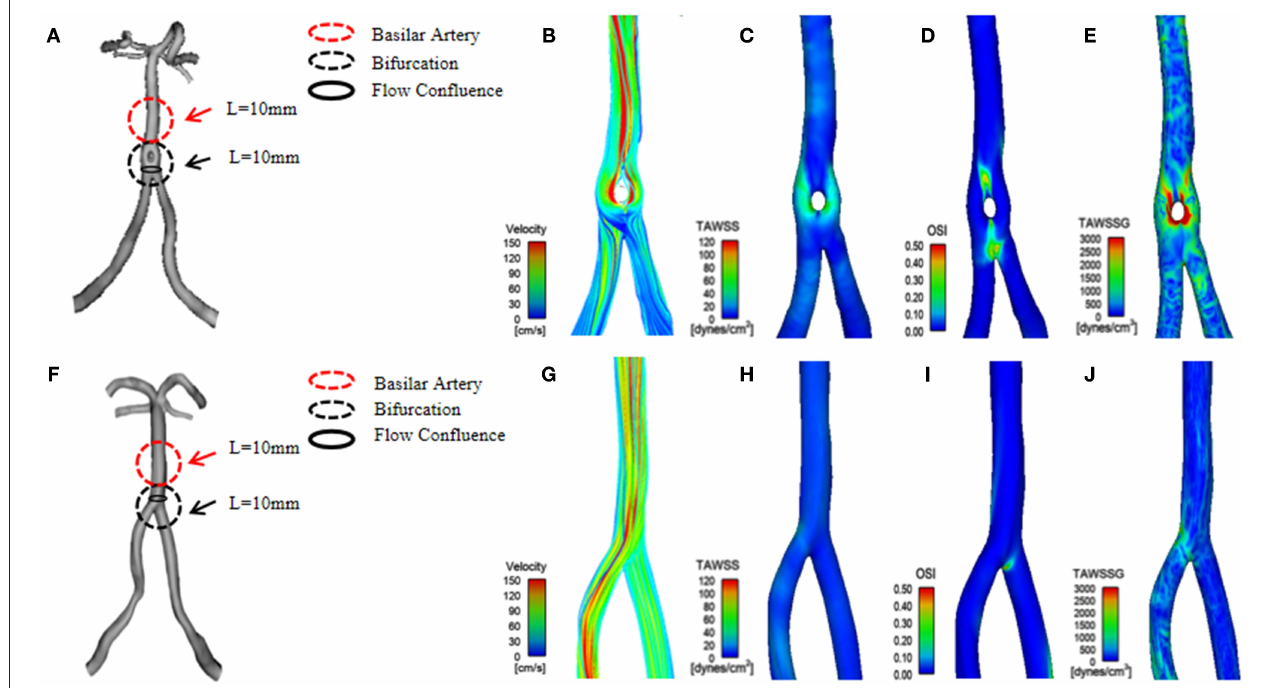
FIGURE 1 | (A) A three-dimensional (3D) geometrical model of basilar artery fenestration (BAF) reconstructed from a patient’s 3D-rotational angiography (3D-RA). (B–E) The hemodynamic distribution of BAF, including the following parameters: velocity, time-averaged wall shear stress (TAWSS), oscillatory shear index (OSI), and time-averaged wall shear stress gradient (TAWSSG). (F) A 3D geometrical model of a normal vertebrobasilar artery reconstructed from a patient’s MRA. (G–J) The hemodynamic distribution (velocity, TAWSS OSI, and TAWSSG) of a normal vertebrobasilar